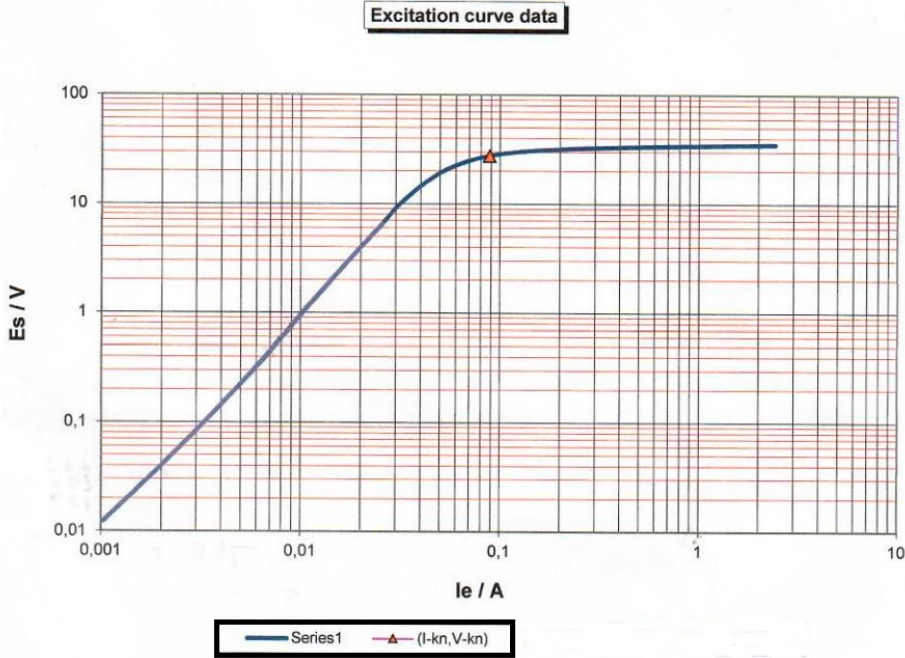
Figure 5. Dependance of the inductance L m on the secondary current of CT. Table 3. Factory data of the saturation magnetic curve.